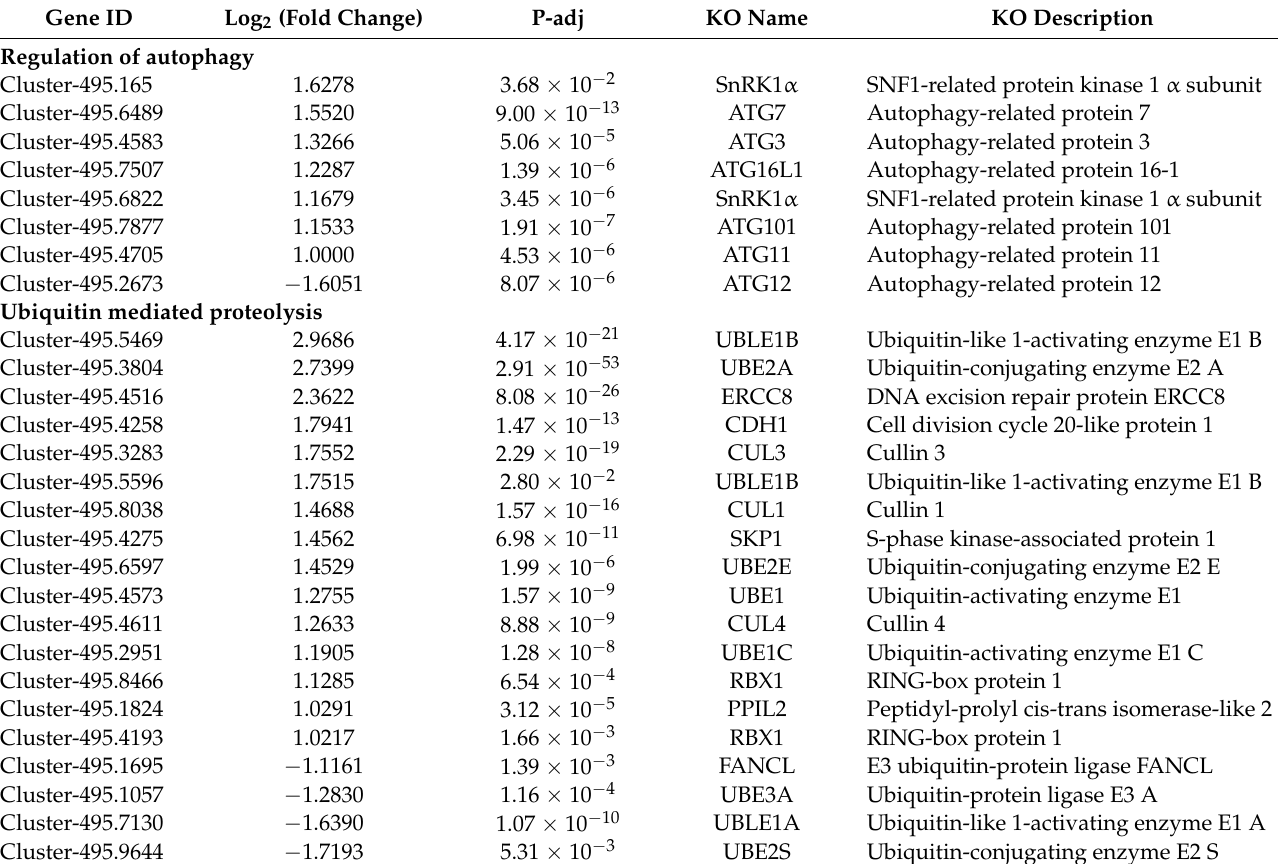
Table 3. Differentially expressed genes in protein